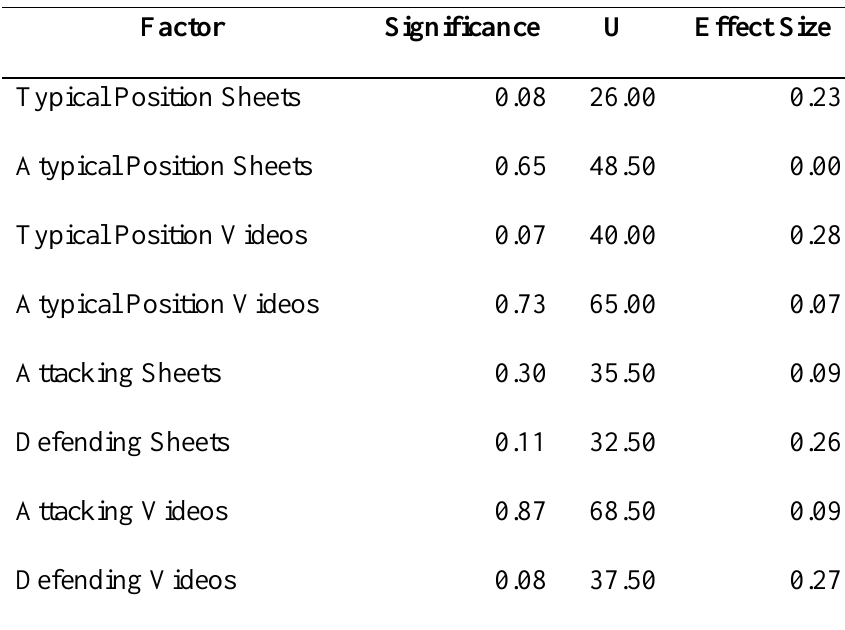
Table 7.6 – Comparisons of Attacker and Defender